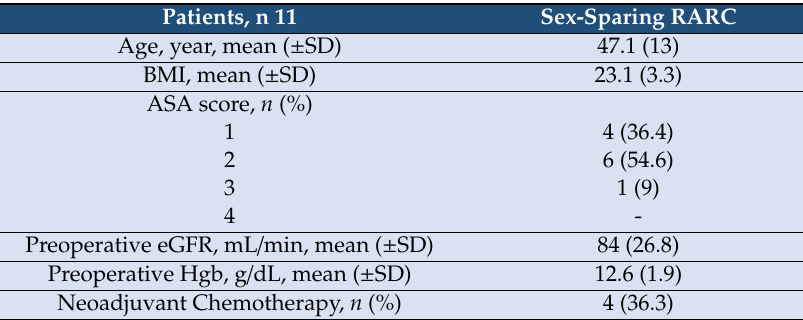
Figure 1. ( a , b ): Kaplan-Meier analysis to report day-time and night-time continence recovery Table 1. Baseline and clinical probabilities.